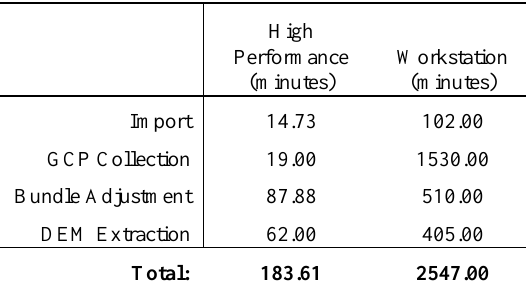
Table 1. Performance comparison between the high performance system and a traditional